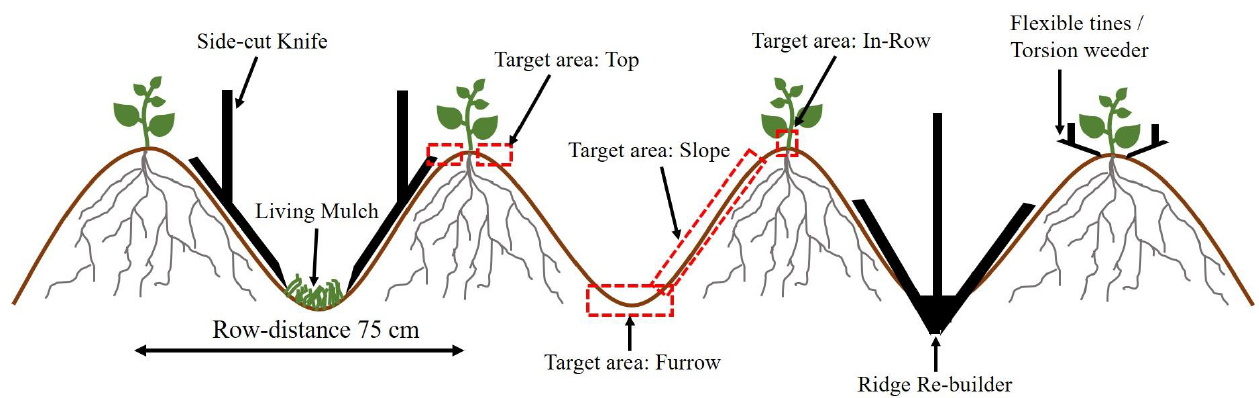
Figure 3. Schematic description of ridge tillage with crops placed on top of the re-compacted ridges and mechanical weeding with flexible tines close to crop rows, down side-cut knives in the slopes and living mulch in the furrows.